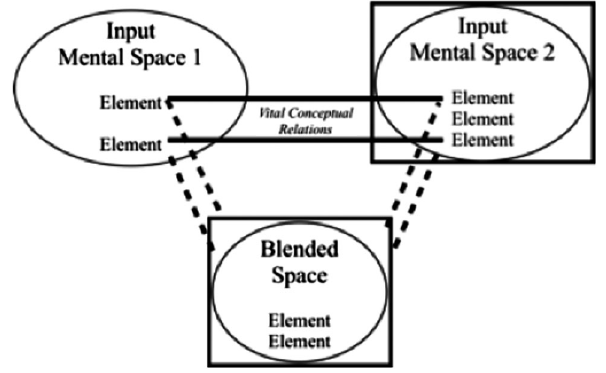
FIG. 1. Generic network map for a conceptual blend. Ovals indicate input and blended mental spaces. Solid lines indicate correspondences between input spaces. Dotted lines indicate elements that are projected into the blended space. Rectangles indicate a space that includes a material